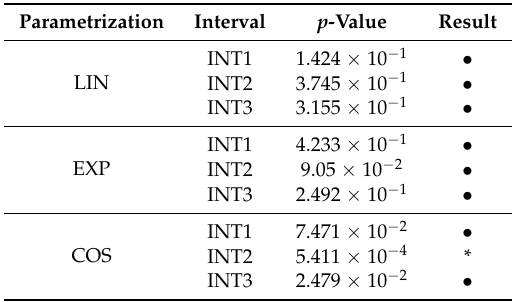
Table 12. Pairwise t-test with Bonferonni correction, in terms of the optimization algorithms employed in the DRTO study, GA and DE. The positive results are marked as an asterisk (*), and the negative with a dot ( •